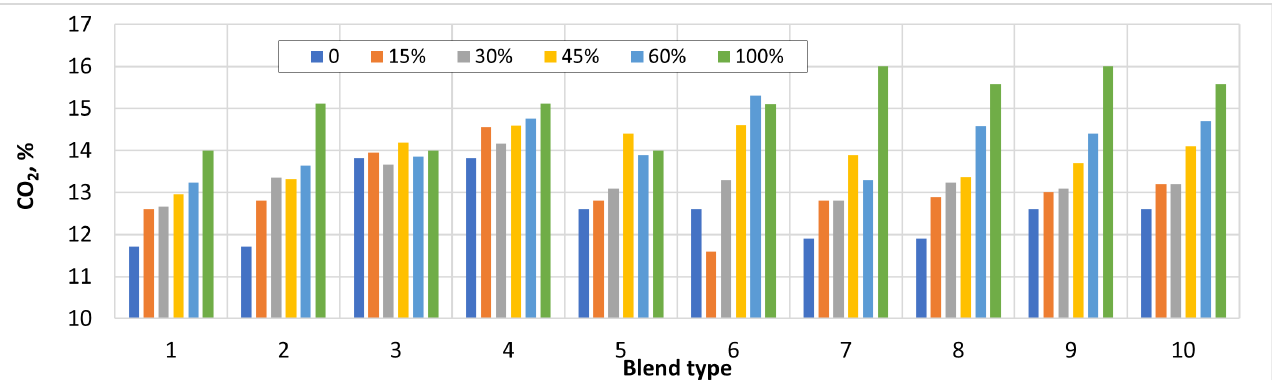
Figure 12. The volume fraction of CO 2 emissions in products of blends (for composition of blends see Figure 4).